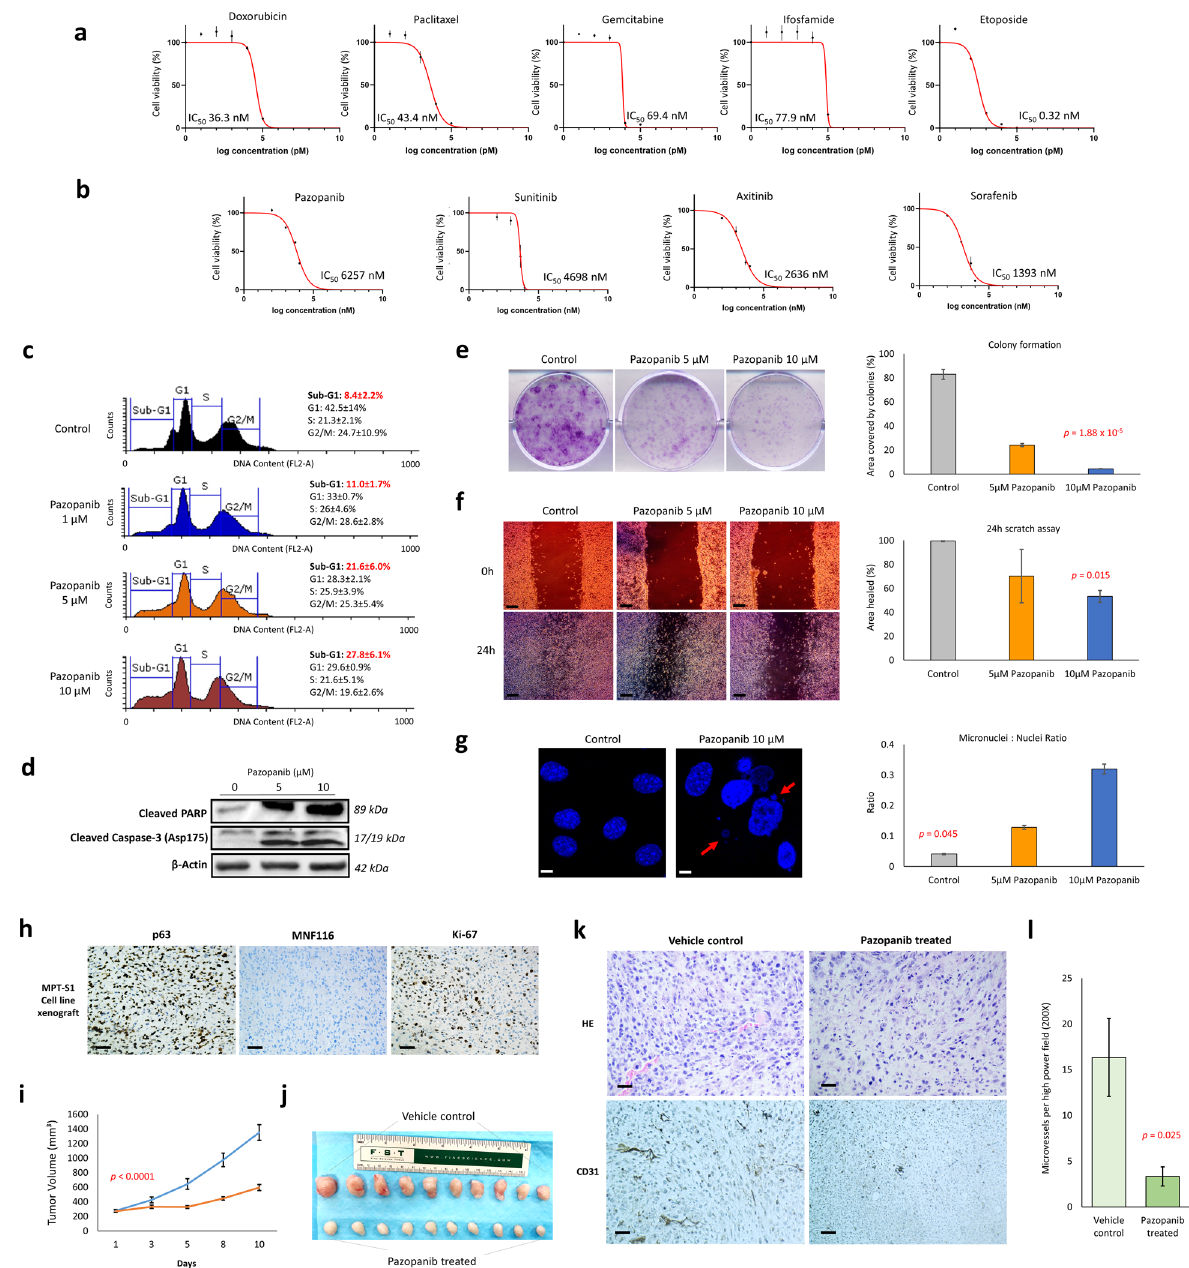
Fig. 3 Response to chemotherapeutic agents and tyrosine kinase inhibitors. a , b In the patient-derived cell line, treatment with several chemotherapeutic drugs and tyrosine kinase inhibitors resulted in reduced viability in a dose-dependent manner. c Pazopanib evoked a dose- dependent increase in the sub-G1 cell fraction ( p = 0.002), d induced cleavage of PARP and caspase-3, e reduced clonogenicity, f decreased cell migration (scale bar: 100 µm) and g induced the formation of micronuclei (scale bar: 5 µm). h The resultant re-transplanted cell line xenograft retained the immunophenotype of the original PDX and primary tumor (scale bar: 50 µm). i , j Pazopanib inhibited tumor growth in our PDX model and k , l reduced microvessel density (mean: 16.3 ± 3.3 versus 4.3 ± 1.0, p = 0.025) (scale bar: 50 µm). All drug treatments were performed in triplicate, and results are represented by mean values and standard apoptosis (Fig. 3d) and reduced clonogenicity (Fig. 3e). Cell migration was inhibited as evident from the scratch assay, as treatment with 5 µM and 10 µM pazopanib resulted in an average of 70.2% and 53.2% “ healed ” scratches, respectively, as compared to mock treatment control (99.6%, p = 0.015) (Fig. 3f). Further- more, pazopanib induced the formation of micronuclei indicating a mode of action by causing chromosomal instability, with micronuclei-to-nuclei ratio scores of 0.04, 0.13, and 0.32 for mock